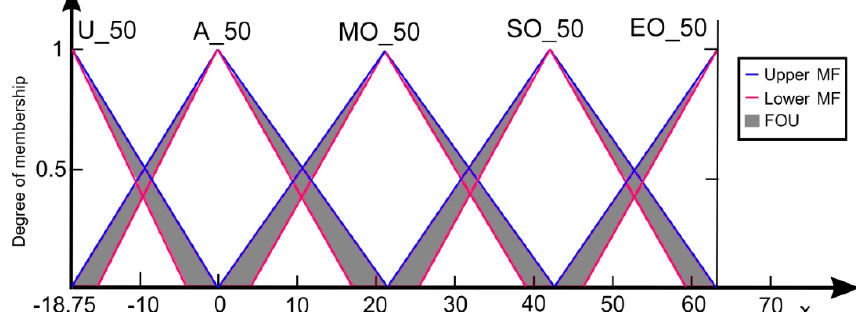
Figure 6. Input variable Average assessment of speed 50 km/h. Used notation: MF—membership function; FOU—footprint of uncertainty. function; FOU—footprint of uncertainty.